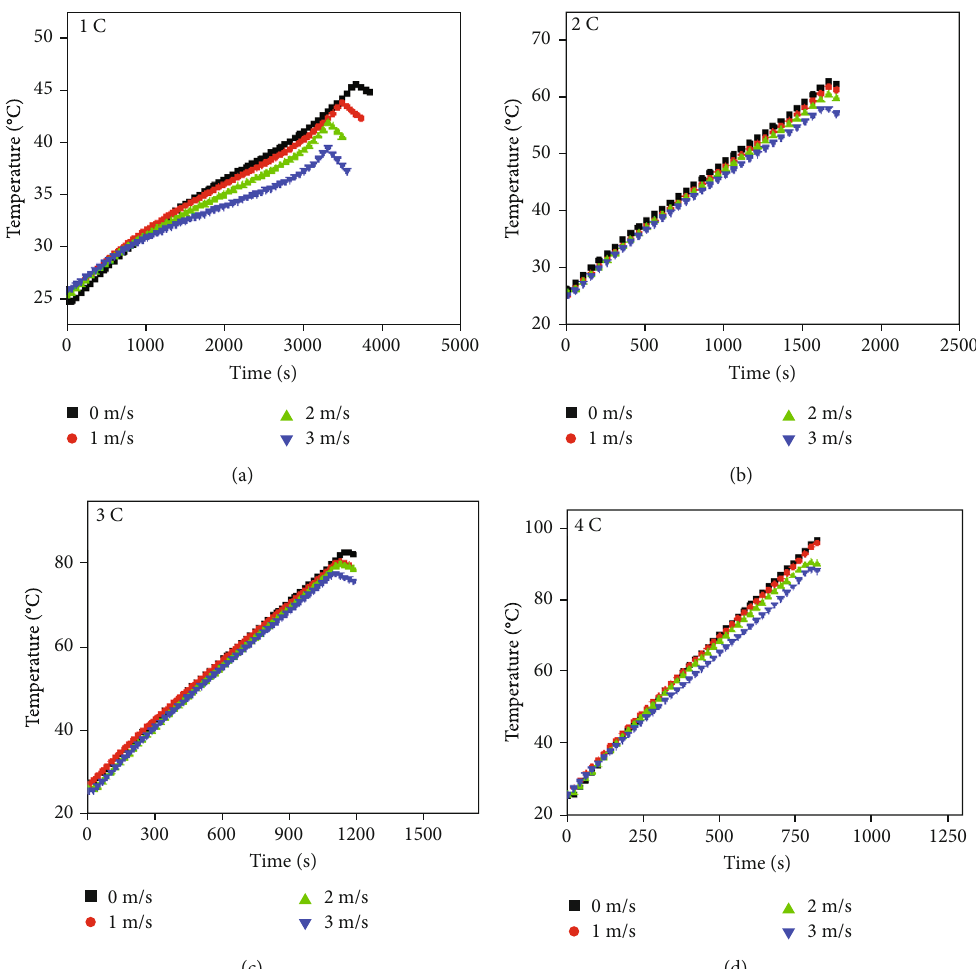
Figure 7: Temperature comparison of the battery modules with various air fl ow rates at di ff erent discharge